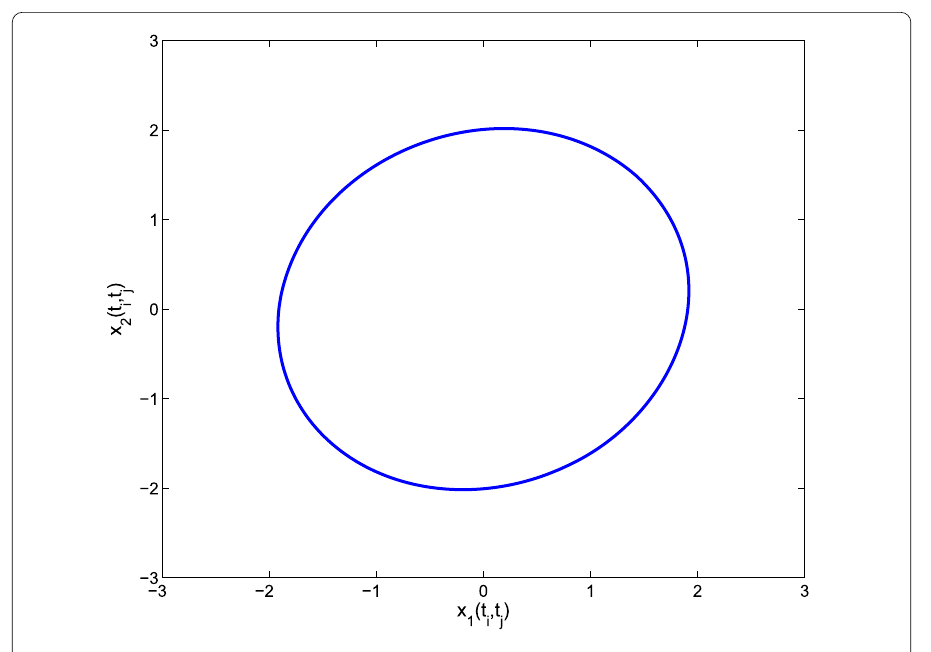
Figure 3 An estimate of the domain of